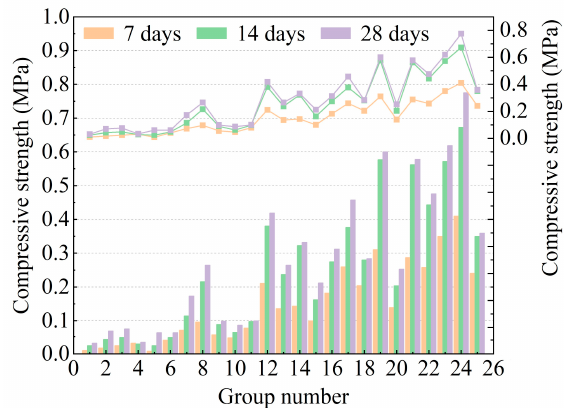
Figure 13. Test results of compressive strength.